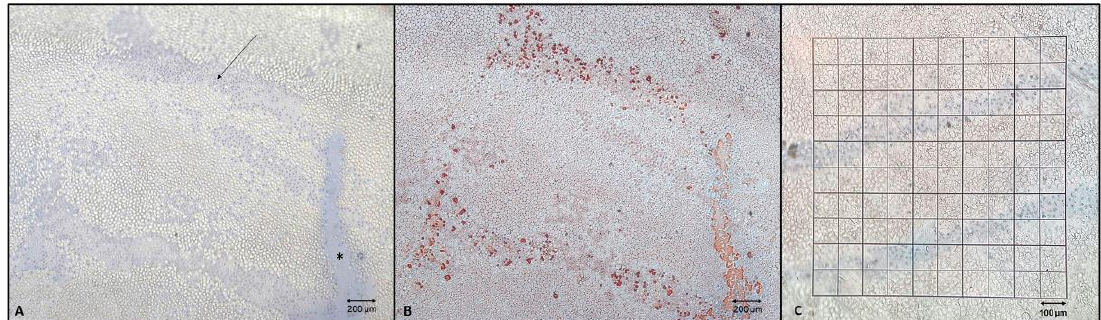
Figure 1. ( A ) Group B, 40 × magnification, Trypan Blue and Alizarin Red, after 72 h of preservation. Cornea with trypan blue positive cells (arrow) on folds and de-cellularized areas (asterisk) displayed by dye suffusion onto Descemet’s membrane. ( B ) Same tissue but stained by Alizarin red dye which only stains the Descemet’s membrane, clearly showing the cell margins and the uncovered areas, confirming what observed with the Trypan Blue staining. ( C ) 100 × magnification, Trypan Blue, archive photo. Trypan blue positive cells localized on the Descemet folds. To perform the mortality assessment, the reticle is overlayed to the image and then the number of small squares covering the areas are counted. To get the percentage, this value is referred to the whole surface of the